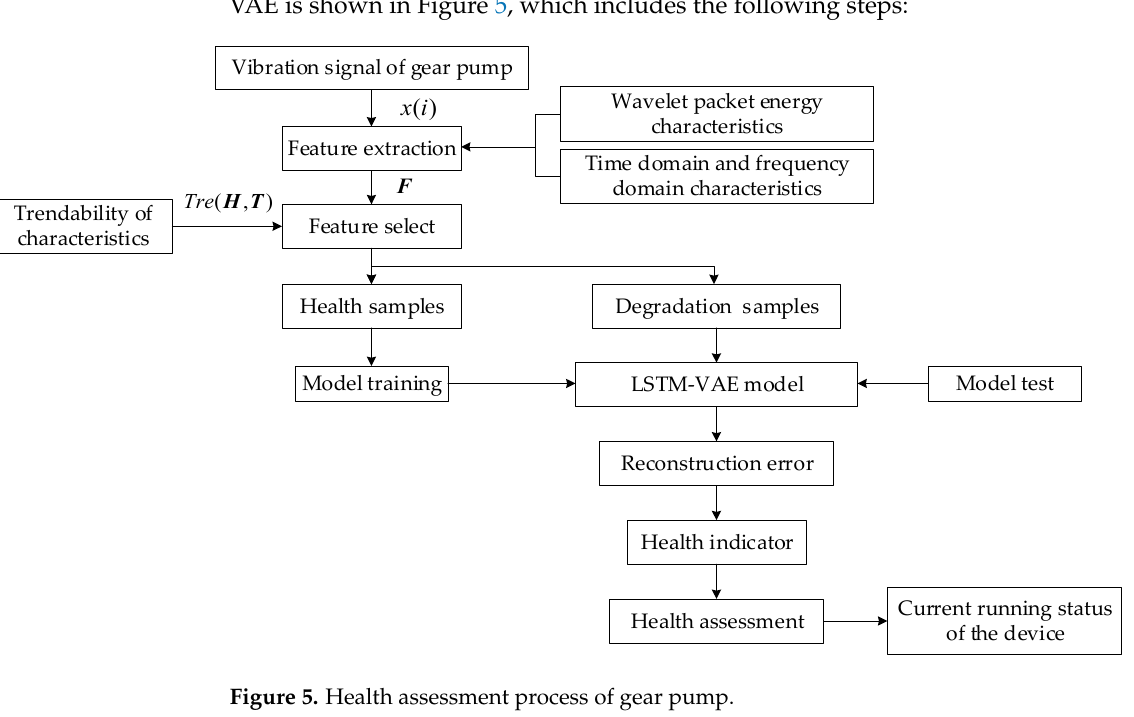
Figure 5. Health assessment process of gear pump.